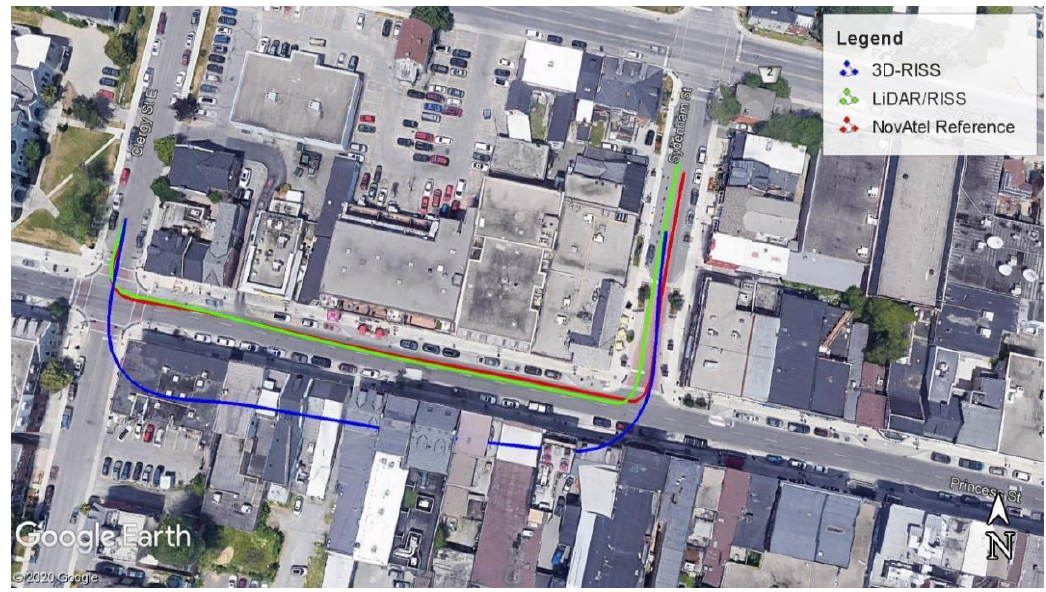
Figure 17. Navigation Solution for 3D-RISS, LiDAR/RISS, and NovAtel Reference during Simulated GNSS Outage 2, First Trajectory.